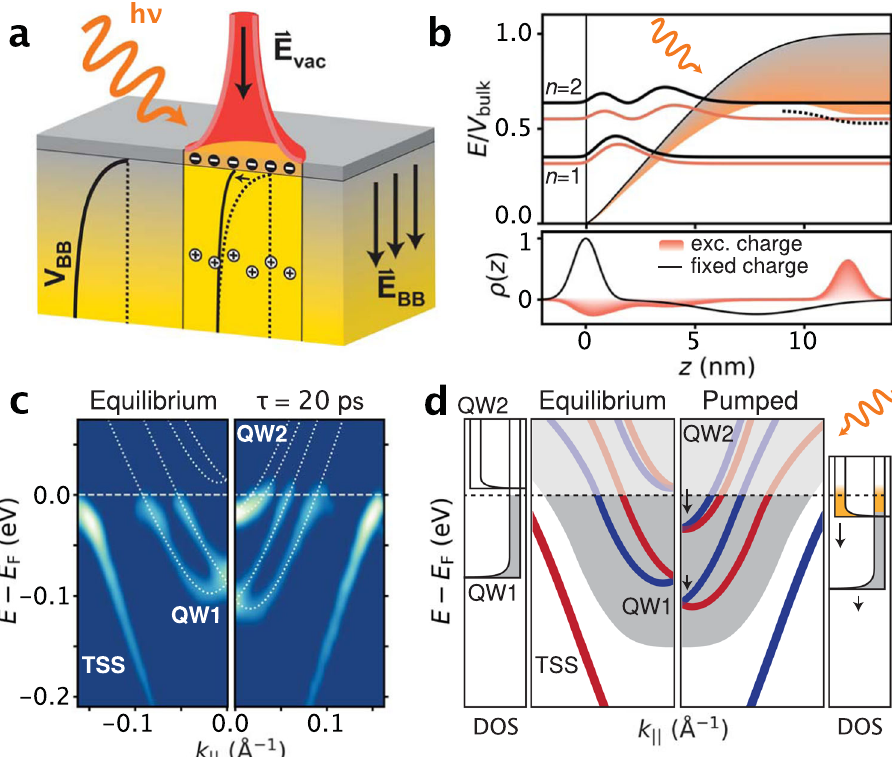
Fig. 1 Tuning quantum well potentials through charge separation. a Diagram of the band-bending in Bi 2 Se 3 inside and outside the illuminated region. Infrared excitation generates excited electron-hole pairs that are separated by the band-bending, reducing the internal electric fi eld. b Photoexcited charge separation decreases the slope of the quantum well potential (gray to orange region). The quantum well energy levels ( n = 1, 2) before illumination (solid curves) are compressed in energy after the pump (dotted curves). c ∂ 2 / ∂ E 2 spectra at equilibrium and after pump pulse demonstrating the spectrum modi fi cation. d Illustration of quantum well level shifts in Bi 2 Se 3 before and after illumination. The gray parabolic region represents the conduction band before quantization. The DOS of Rashba-split bands exhibits a singularity near the band bottom. The photo-induced spectrum modi fi cation enables toggling of a Lifshitz